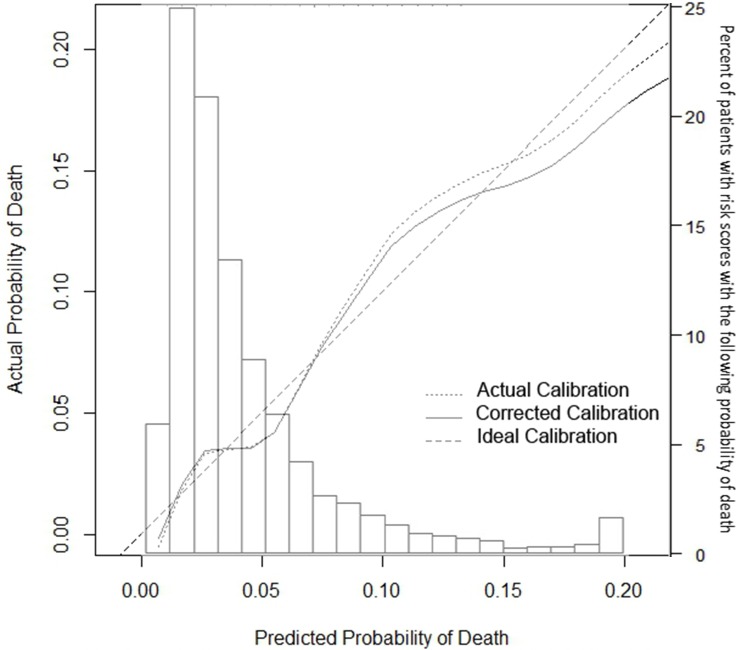
Histogram of the distribution of predicted probability of death in the derivation cohort and superimposed calibration curve describing the relationship between predicted and actual risk of death in the year after starting ART.